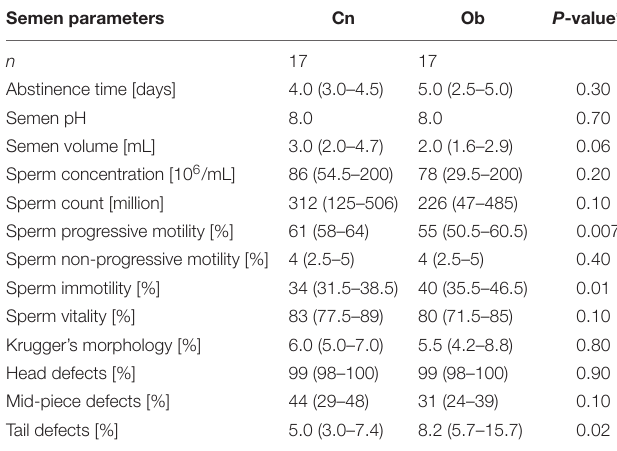
TABLE 2 | Anthropometrical and biochemical features of participants.